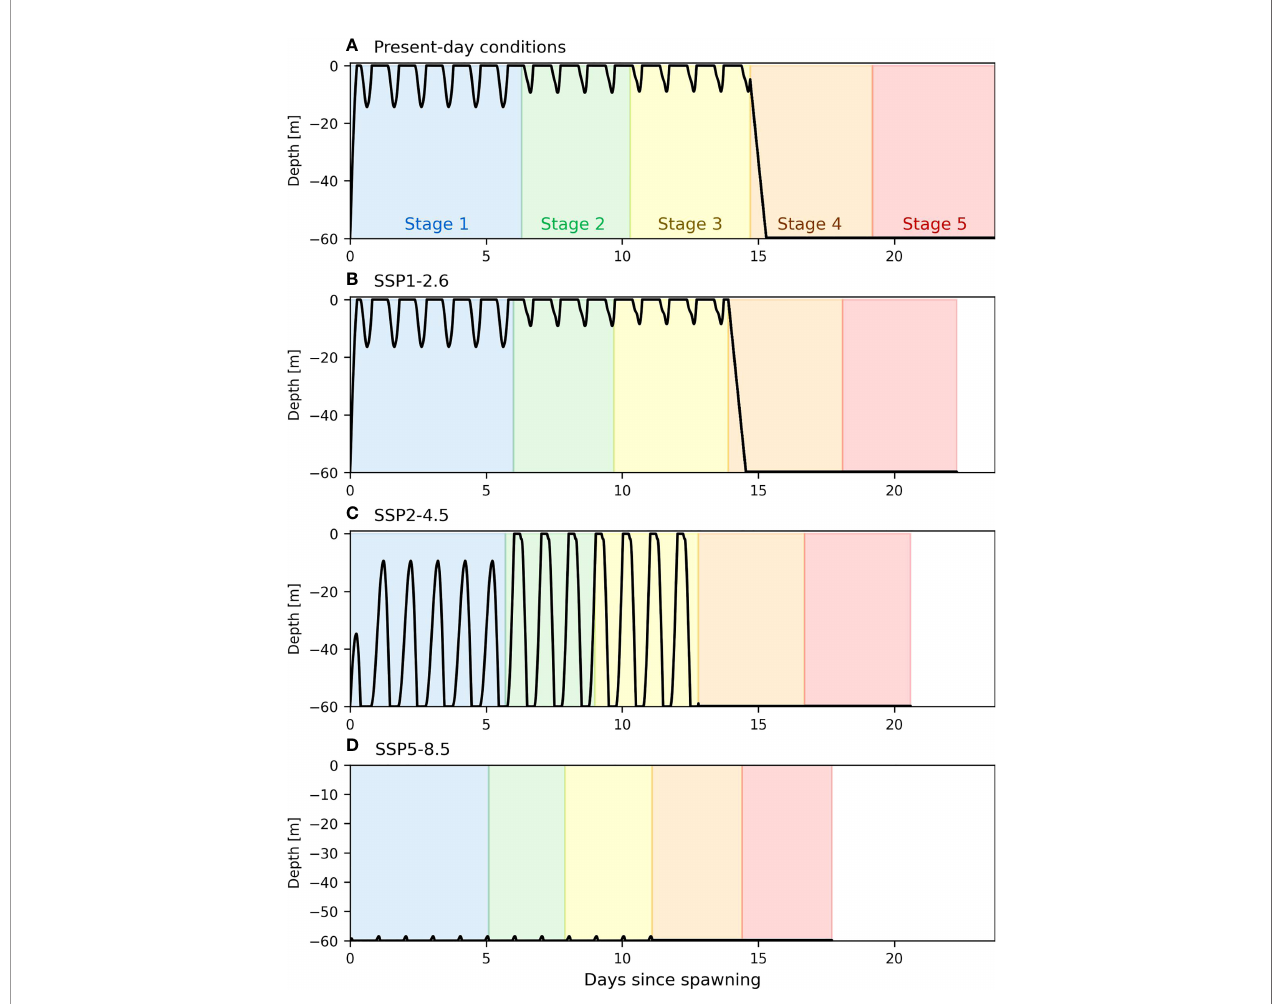
FIGURE 3 | Theoretical vertical movements (black line) of a stone crab larva spawned at a depth of 60m through the fi ve larval stages (each represented by a different